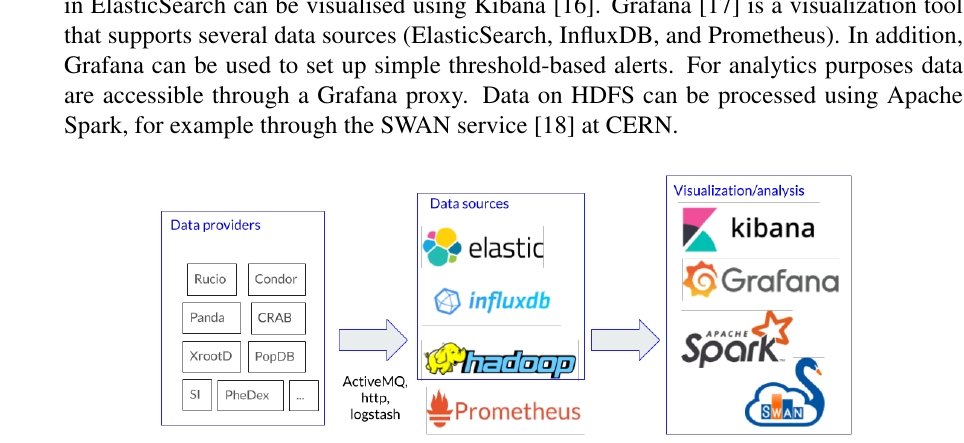
Figure 1. The architectural diagram of the MONIT infrastructure at CERN, as used by the CMS monitoring